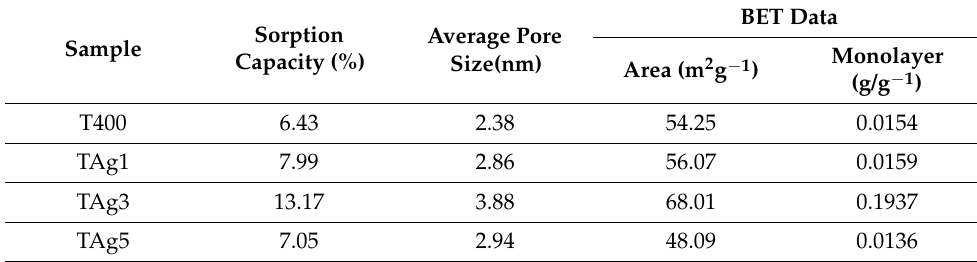
Table 2. BET data of pure TiO 2 and Ag doped TiO 2 nanostructured